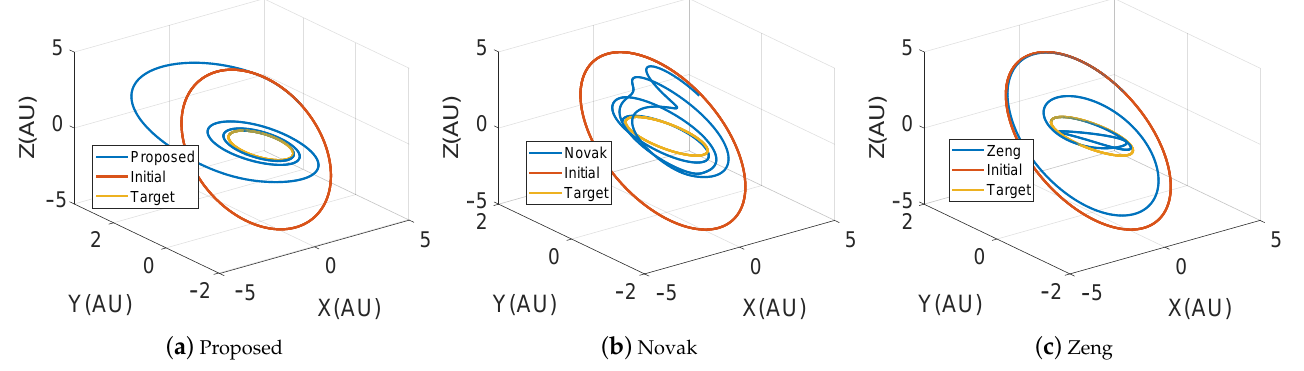
Figure 6. Rendezvous result of three methods when r 1 > r 2 .